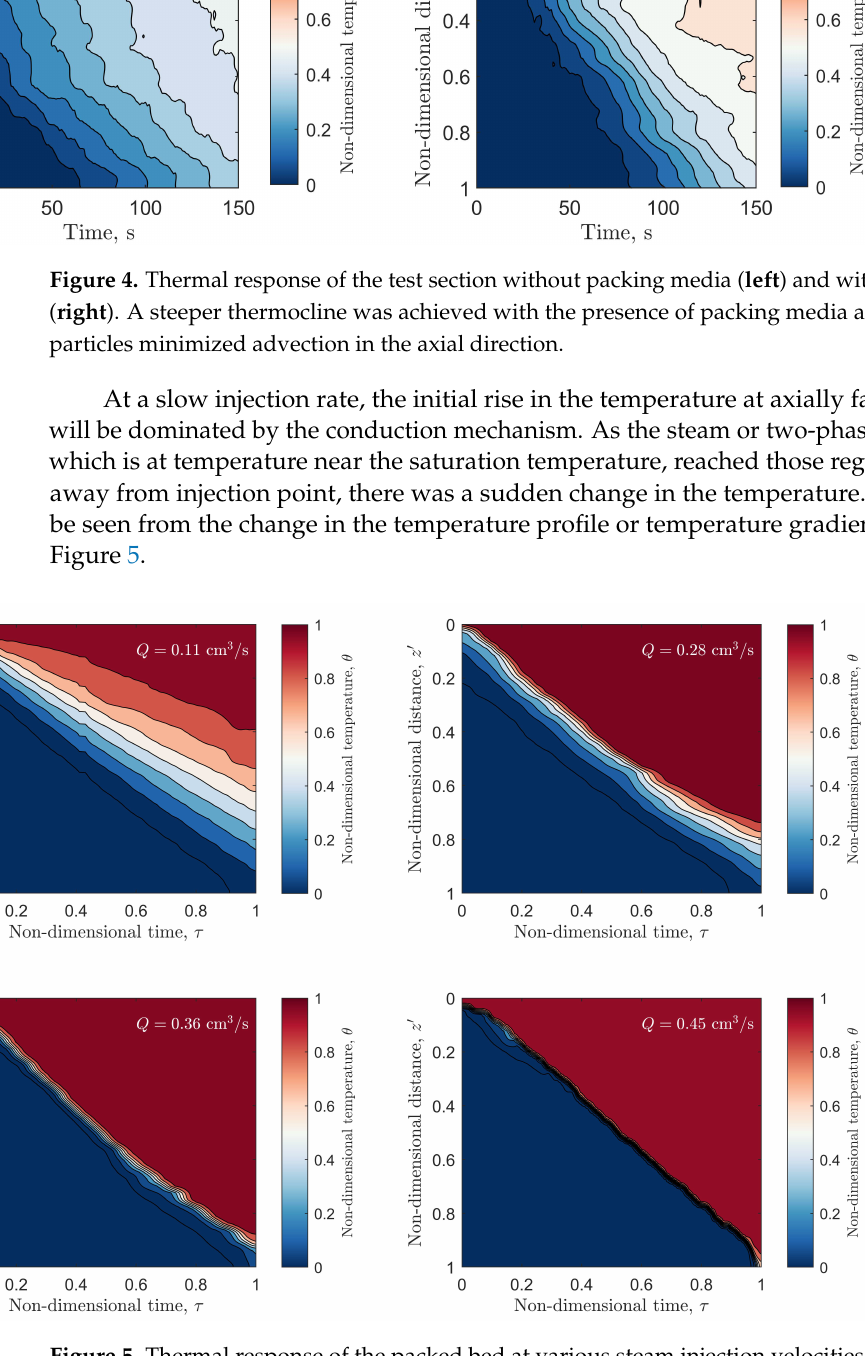
Figure 5. Thermal response of the packed bed at various steam injection velocities. The conduction mechanism was dominant at slow injection velocities, as indicated by a thick intermediate zone between the hot and cold